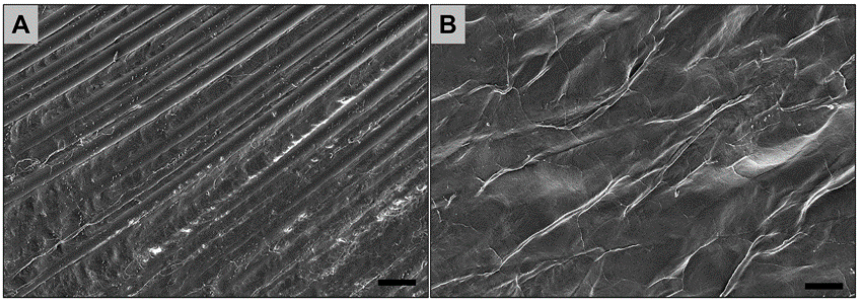
Figure 4. Exemplary scanning electron microscopy (SEM) images of the analyzed membranes. ( A ) dPTFE membrane (500× magnification, scale bar = 20 µm); ( B ) collagen membrane (500× magnification, scale bar = 20 µm).